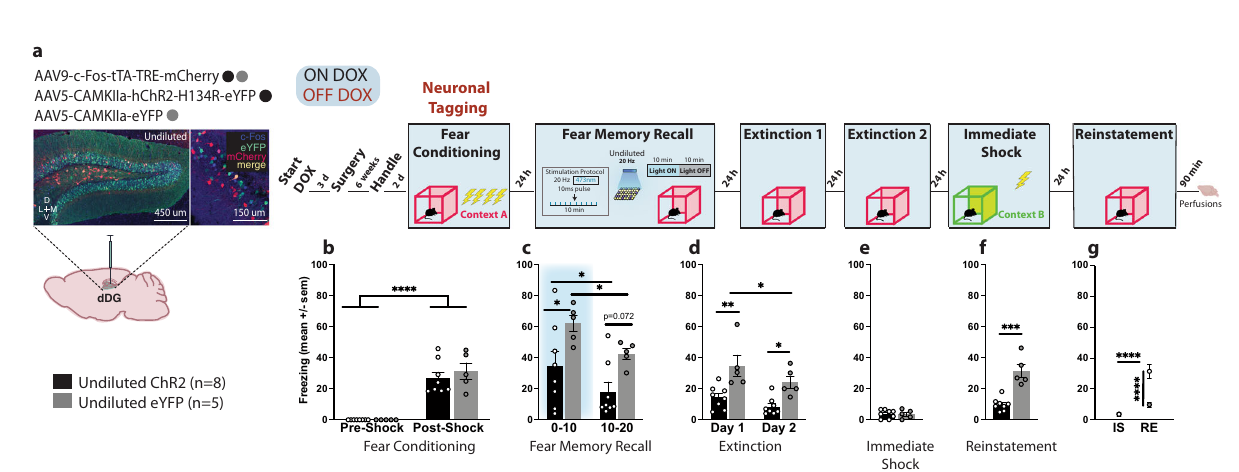
Fig.6|Ataleoftwomemories.a Viralstrategyandexperimentaldesign.Toassess whetherourreconsolidation-basedmanipulationwasabletoaltertheoriginalfear engram, we combined two viral strategies. All mice were injected with c-Fos-tTA- TRE-mCherrytotagdDGcellsencodingtheFCepoch.Micewerealsoinjectedwith either undiluted AAV5-CaMKIIa-hChR2-H134R-eYFP or undiluted AAV5-CaMKIIa- eYFPtorandomlylabeldDGneurons.Micethenunderwentthesameexperimental protocol as before. b All mice froze post-shock (two-way RM ANOVA: F(1,11)=85.26, P <0.0001). c During recall, stimulation produced decreases in freezing(0 – 10)( P =0.0392)inChR2-micecomparedtoeYFPcontrols(two-wayRM ANOVA: F(1,11)=20.32, P =0.0009, Time; F(1,11)=6.468, P =0.0273,